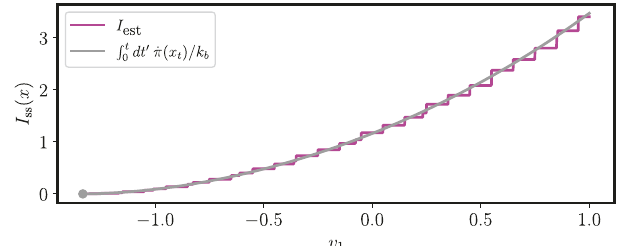
Fig. 6 | Coarse-grained bound for non-zero vorticity. Comparison of the upper bound to I ss ( x 0 ) in terms of the coarse-grained entropy production rate _ π for the pointsinthegraytrajectoryinFigs.1and5withthefunction I est ð x Þ = (cid:2) log ð P ss ð x ÞÞ = Ω obtained from the exact steady state